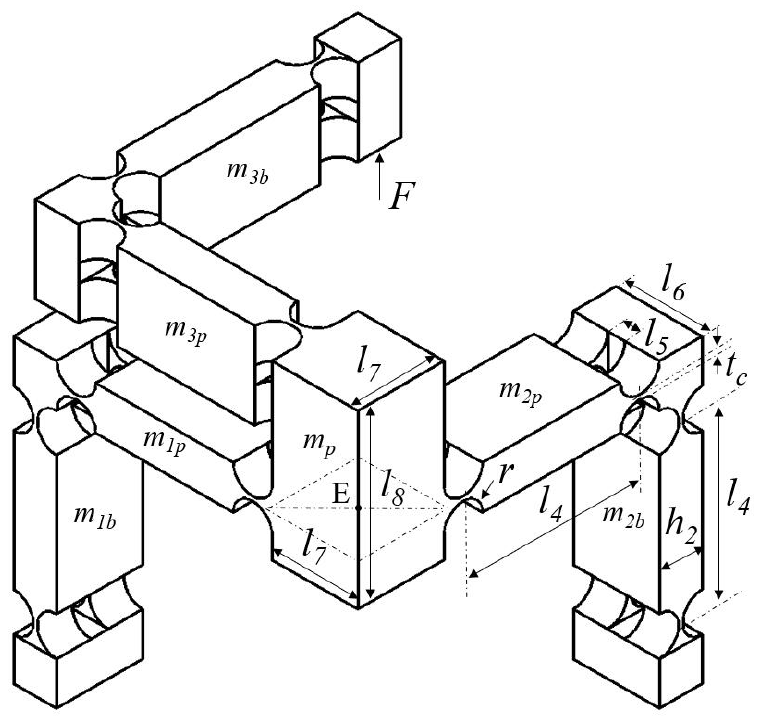
Figure 5. Schematic of the motion platform and three